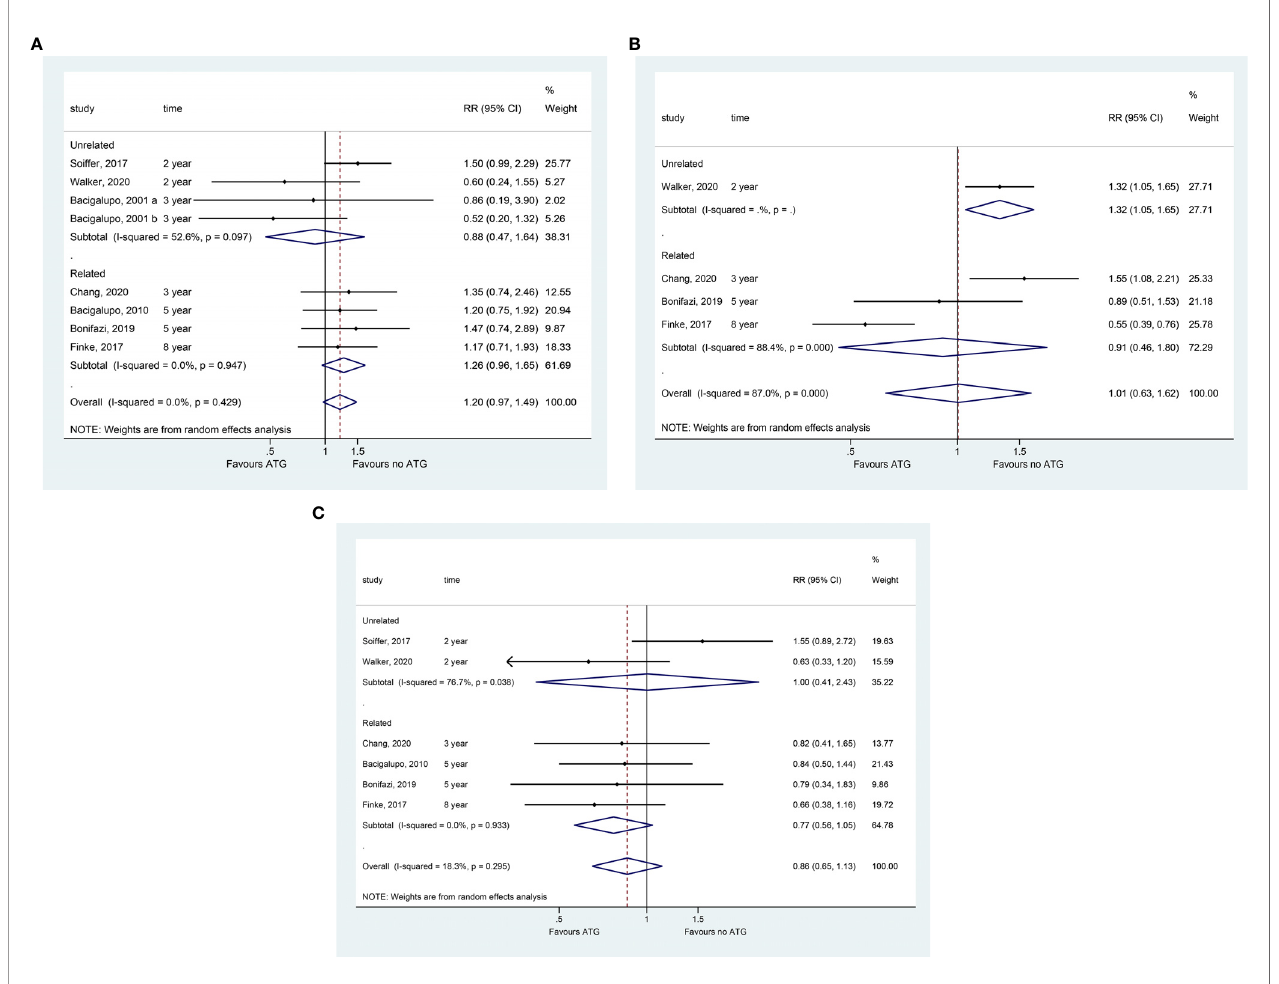
FIGURE 3 | Forest plot for the incidence of relapse (A) , RFS (B) , and NRM (C)